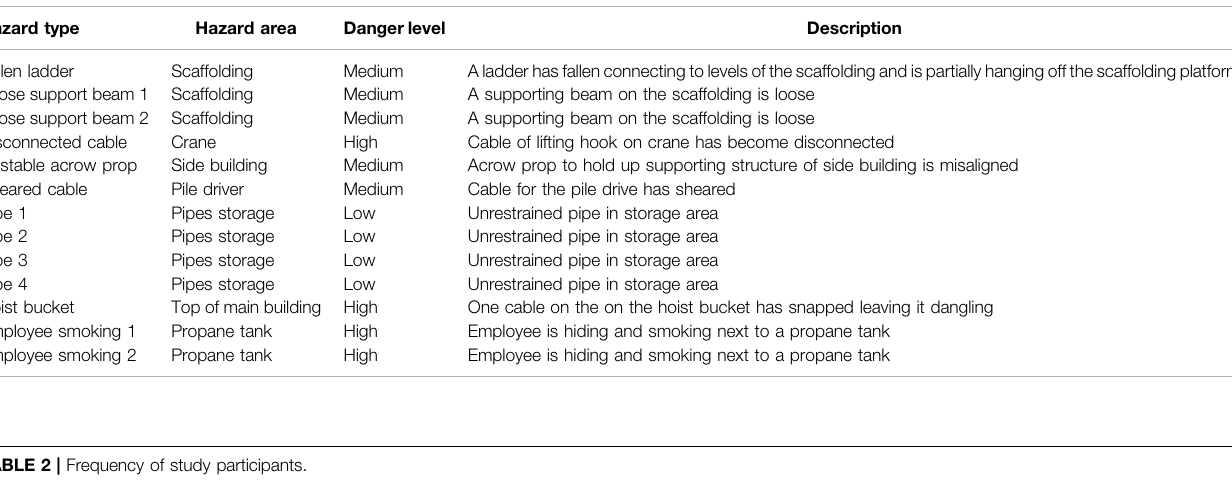
TABLE 1 | Description of all hazards in the game.